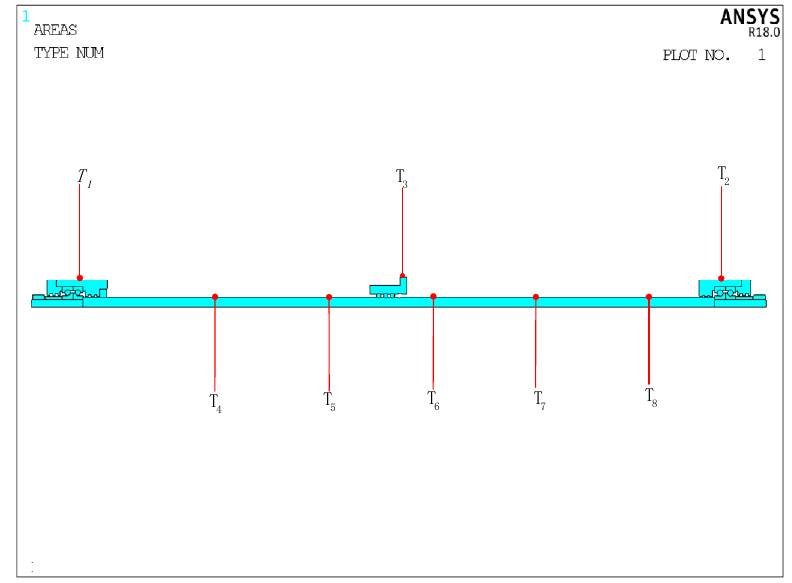
Figure 9. Location points T1–T8 in ANSYS software.